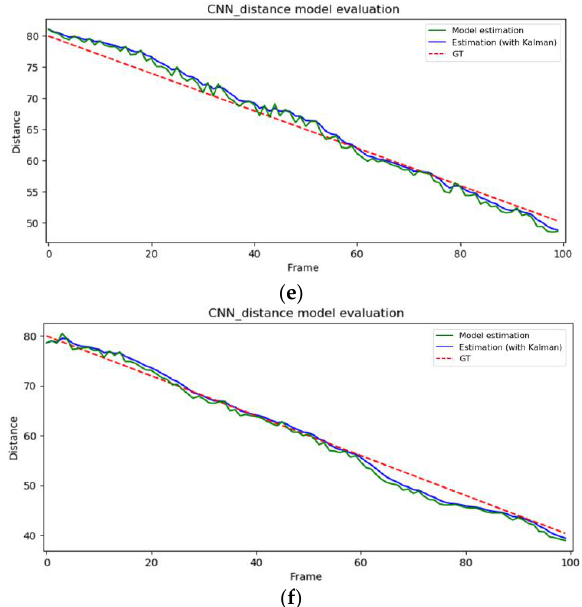
Figure 19. Distance estimation from six different synthetic videos. ( a ), ( c ) and ( d ) are crossing cases, and ( b ), ( e ) and ( f ) are head-on cases. Table 4. Estimated distance vs. ground truth.